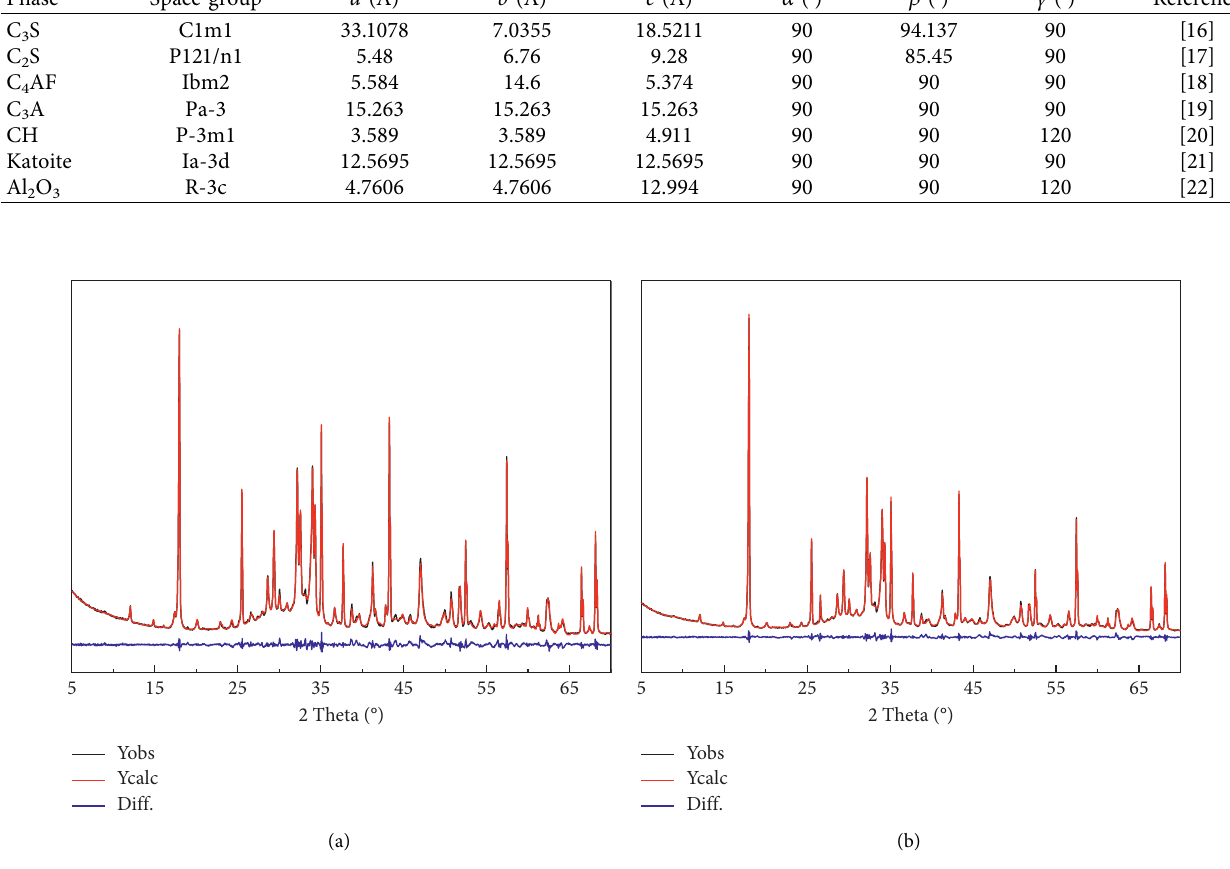
Figure 3: The XRD-Rietveld refinement patterns: (a) inner part; (b) outer part. Table 5: The results of XRD-Rietveld